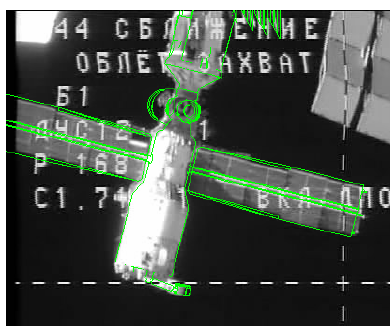
Figure 10. Initial pose estimate